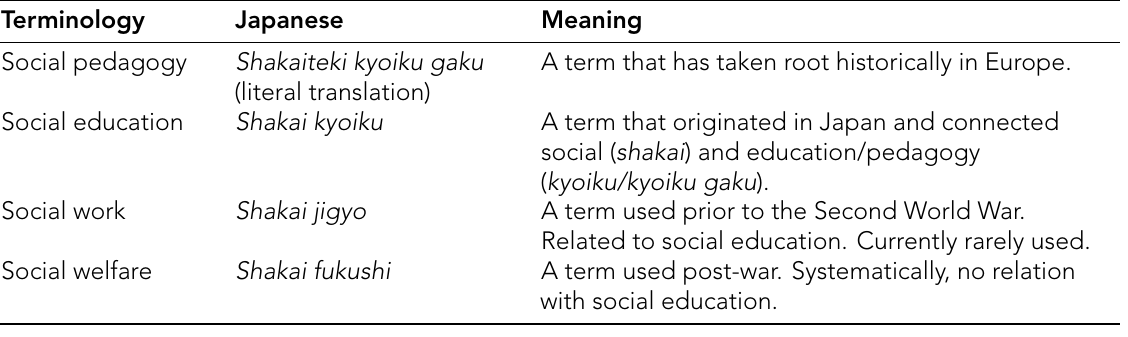
Table 1. Terminology used in this